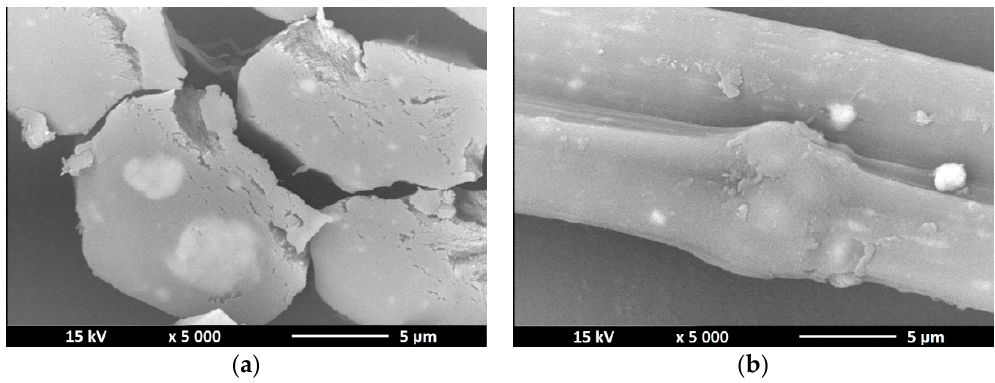
Figure 7. SEM images of cross section ( a ) and surface ( b ) of alginate fibers with a 7% TiO 2 nano additive.